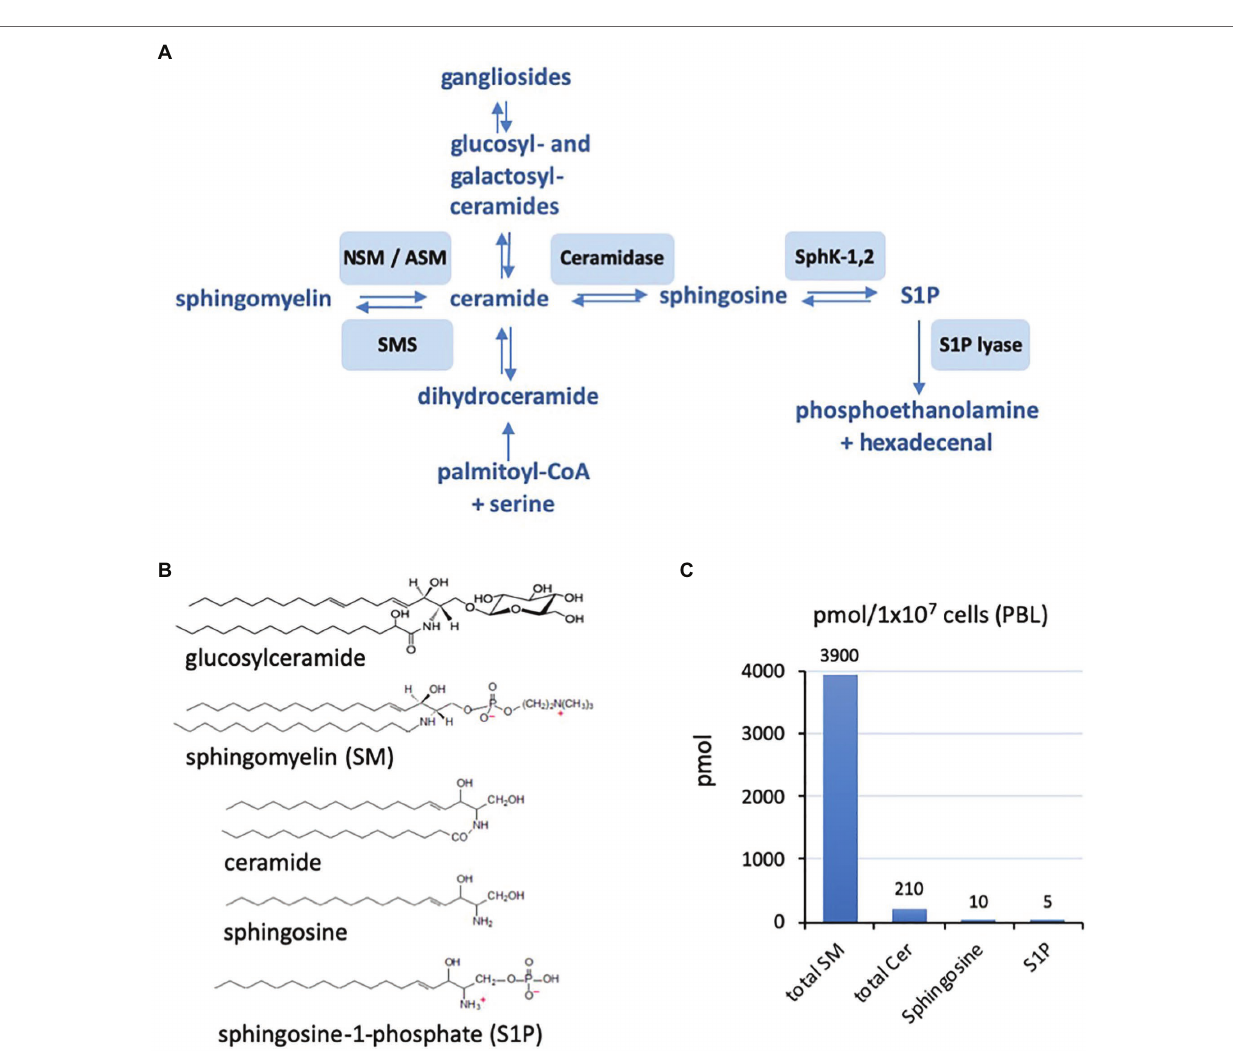
FIGURE 1 | (A) Schematic representation of the sphingolipid metabolism from de novo synthesis from palmitoyl-CoA and serine to the final degradation to phosphoethanolamine and hexadecenal. Involved enzymes are neutral and acid sphingomyelinase (ASM; neutral sphingomyelinase, NSM), sphingomyelin synthetase (SMS), ceramidase, sphingosine kinases 1 and 2 (SphK-1,2), and sphingosine-1-phosphate (S1P) lyase. (B) Examples of the chemical structures of sphingolipids with sphingomyelin (SM) and ceramides of chain length 16 (C16). (C) Characteristic ratios of amounts of SM, ceramide (Cer), sphingosine, and sphingosine-1-phosphate (S1) in primary human peripheral blood lymphocytes (PBL; example form our own